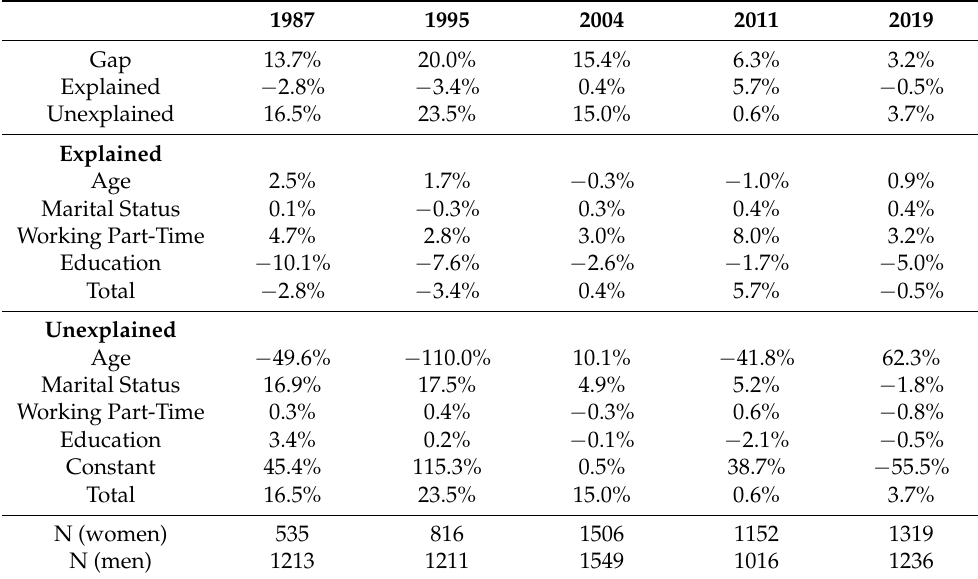
Table A4. Decomposition results from RIF regressions for selected years at the 50th percentile.